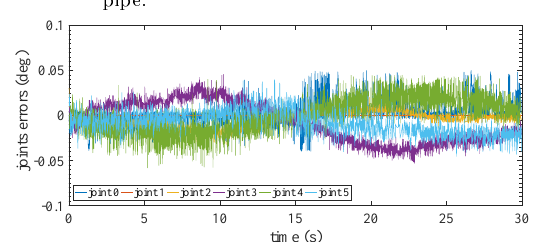
Fig. 16: Joint errors of six joints in the case of static pipe.